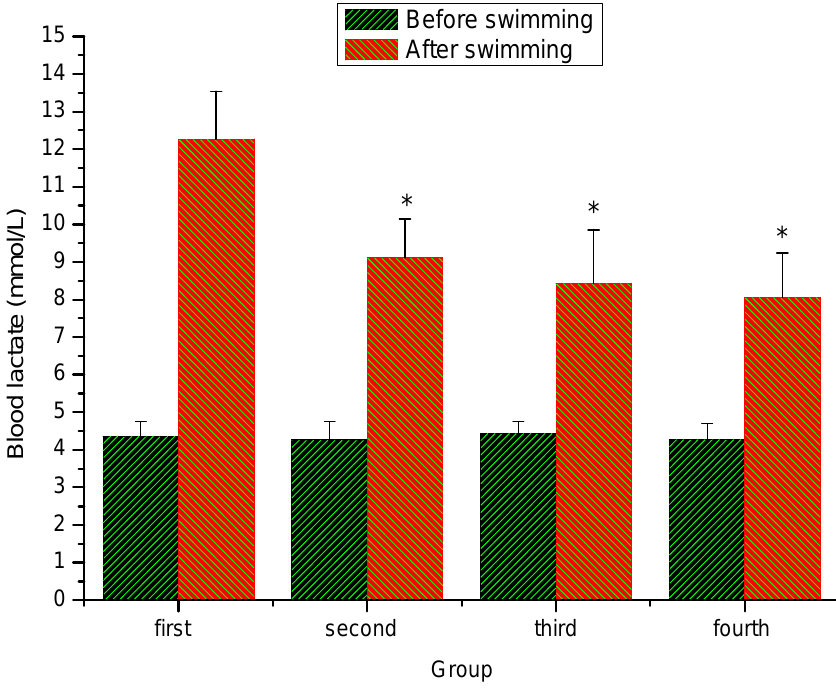
Figure 3. Effect of ASSE on blood lactate of mice. Values represent the means ± SE (n = 10 per group). *P < 0.05 when compared to control